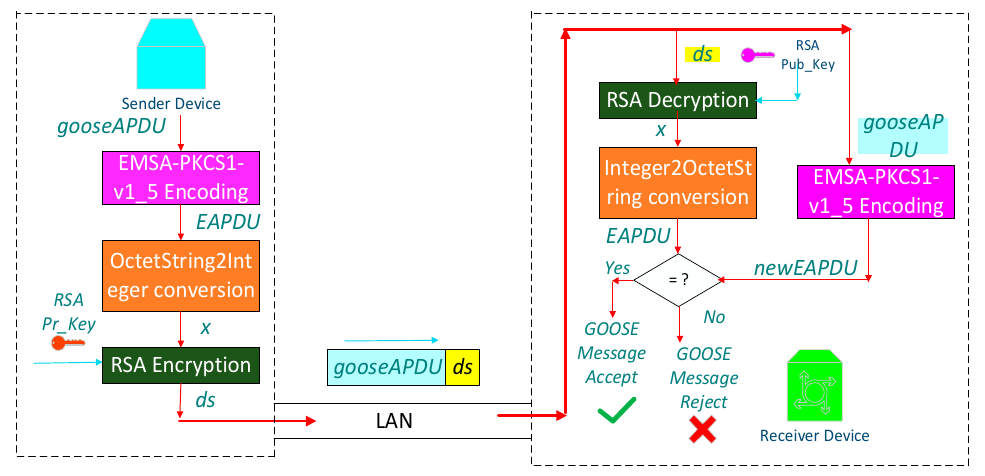
Figure 6. Generation and verification using of digital signature RSASSA-PKCS1-v1_5.